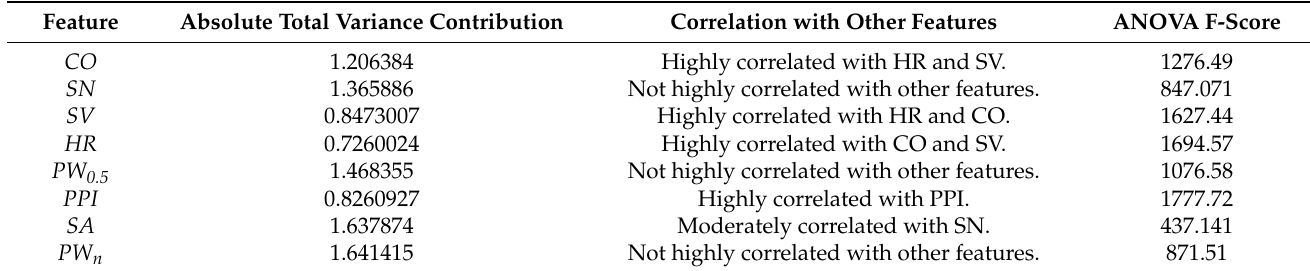
Table 3. The Analysis of the Proposed Features Set.